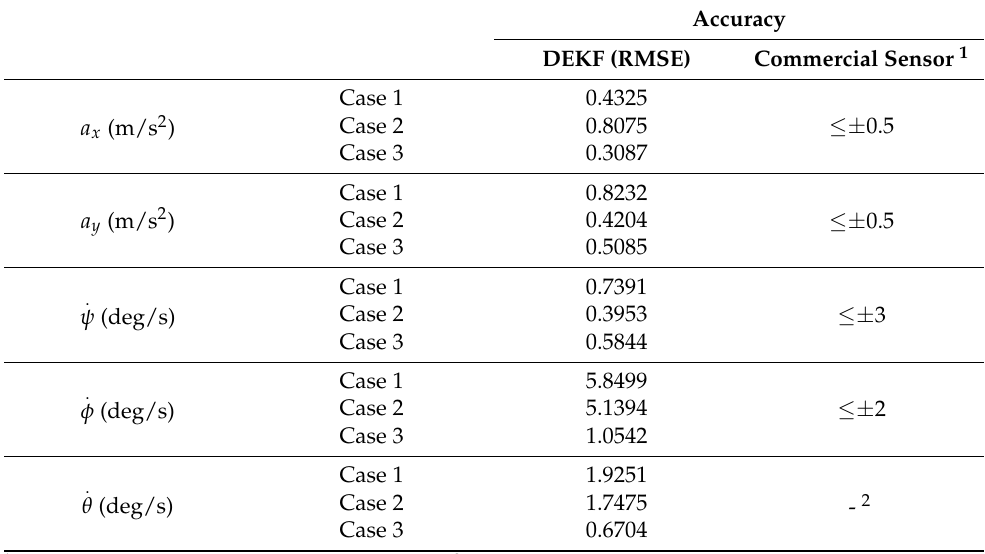
Table 7. RMSE calculation results of DEKF and accuracy obtained from SMI860 datasheet.